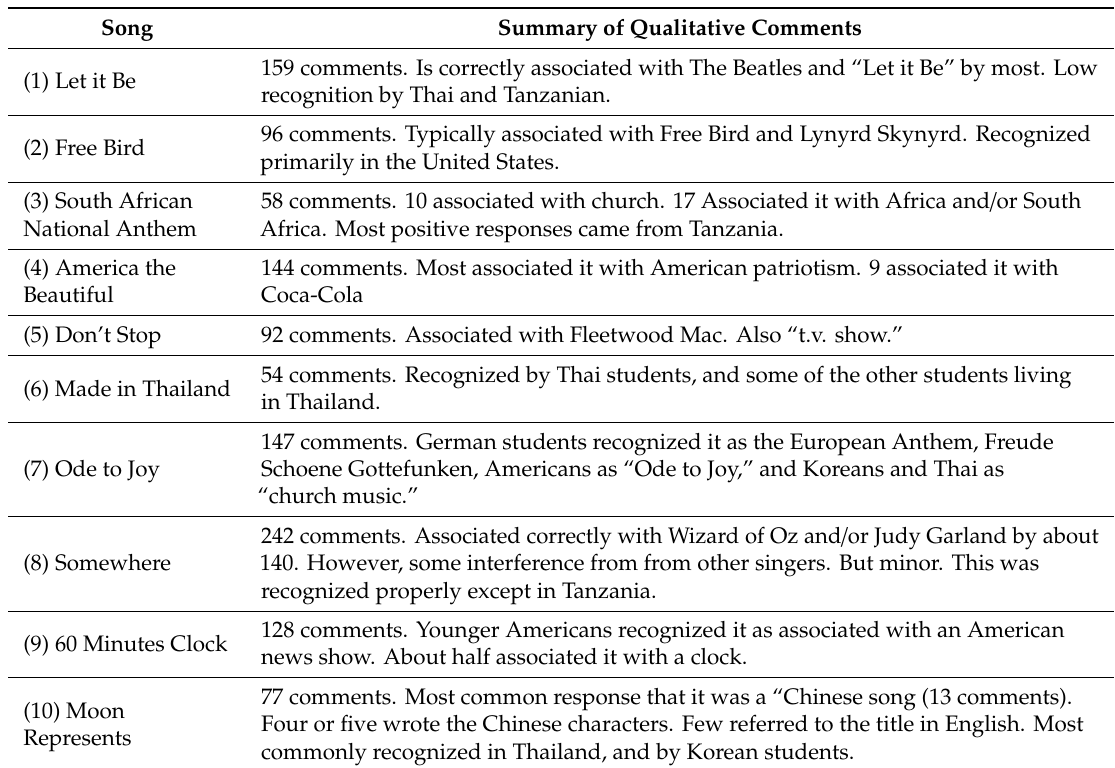
Table 7. Summary of qualitative